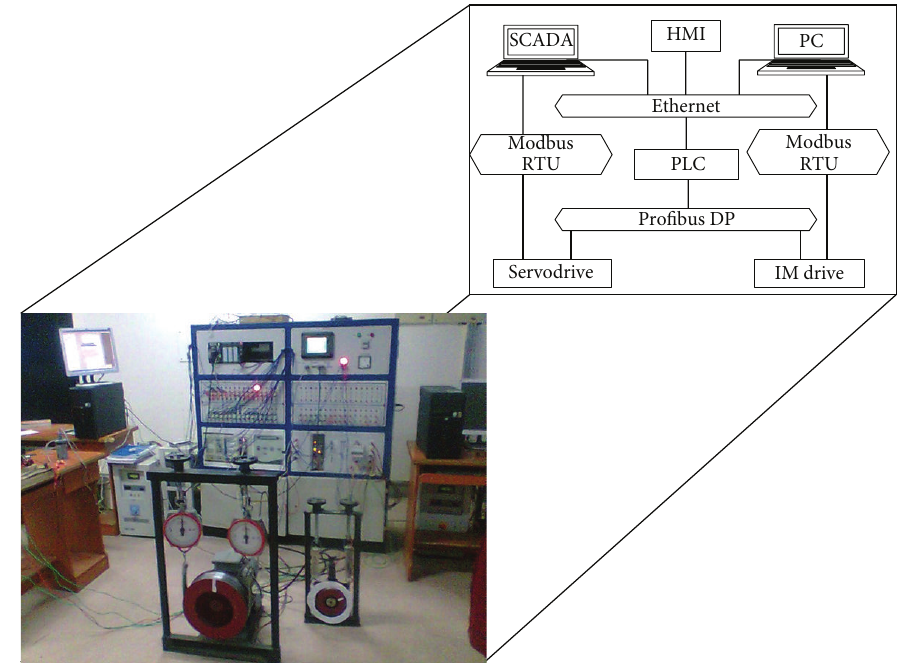
Figure 4: Schematic layout of distributed drives laboratory